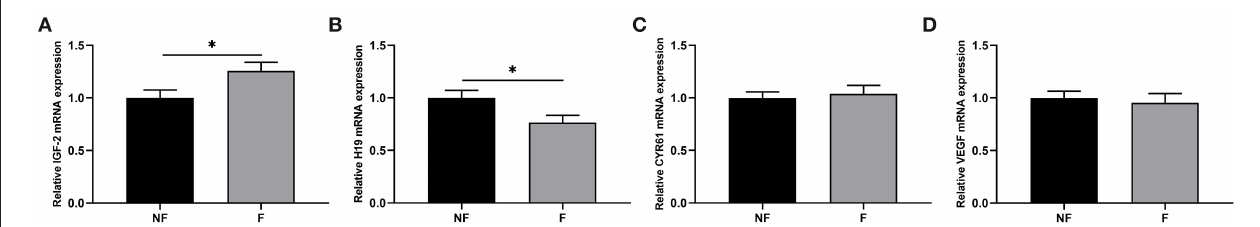
FIGURE 6 | Effects of fiber supplementation in gestation diet on gene expressions related to placental development of sow. (A) Insulin-like growth factor 2 (IGF-2); (B) H19; (C) Cysteine-rich 61 (CYR61); (D) Vascular endothelial growth factor (VEGF). NF, sows fed with a semi-purified basal diet (0.01% dietary fiber); F, sows fed with a semi-purified basal diet supplemented with 8.33 g/kg inulin and 200 g/kg cellulose. Values are mean ± standard error ( n = 5). Significant differences are displayed in the figures by * P < 0.05.